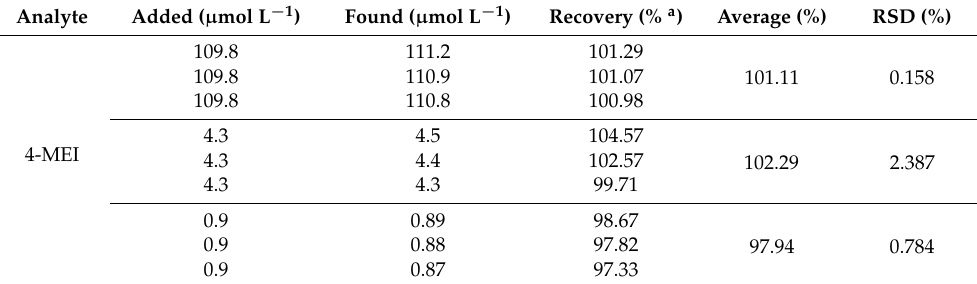
Table 3. Accuracy of the method for sample solutions spiked at different concentrates ( n =